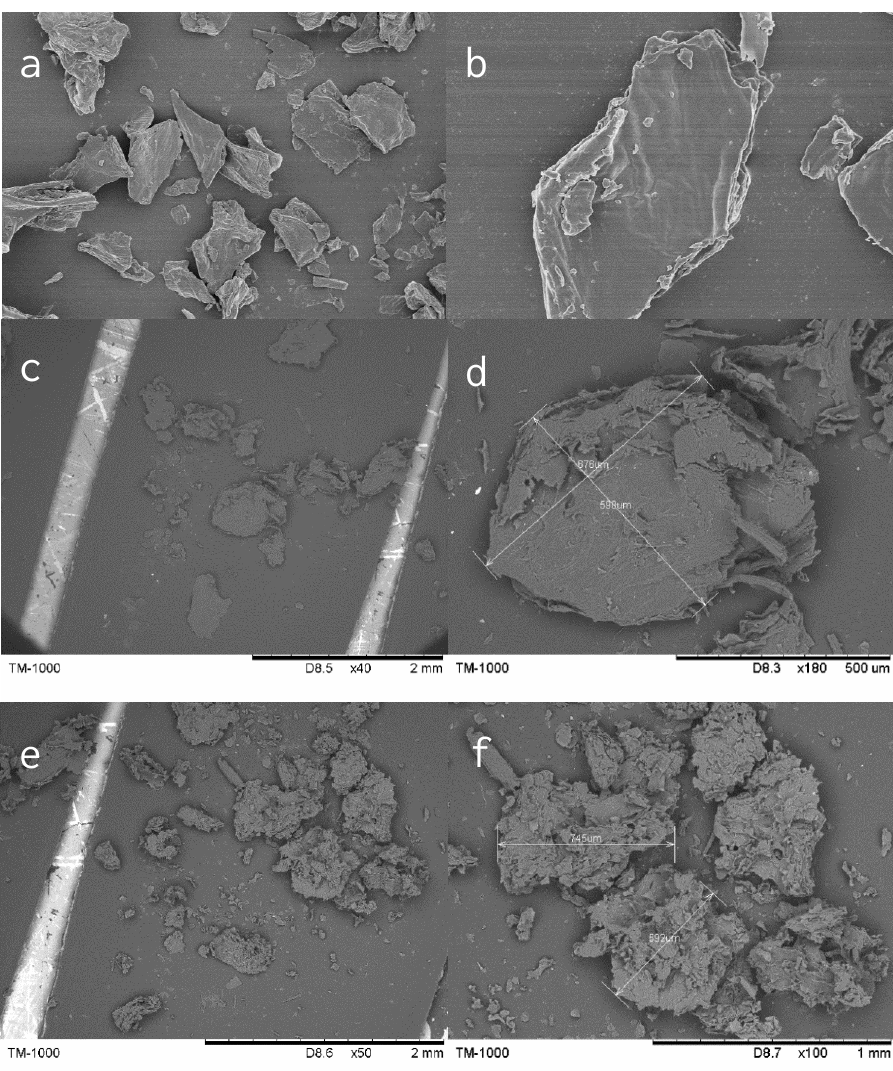
Figure 2. SEM images of PP ( a and b ), NHP ( c and d ) and EP ( e and f ) samples of pomelo peel.